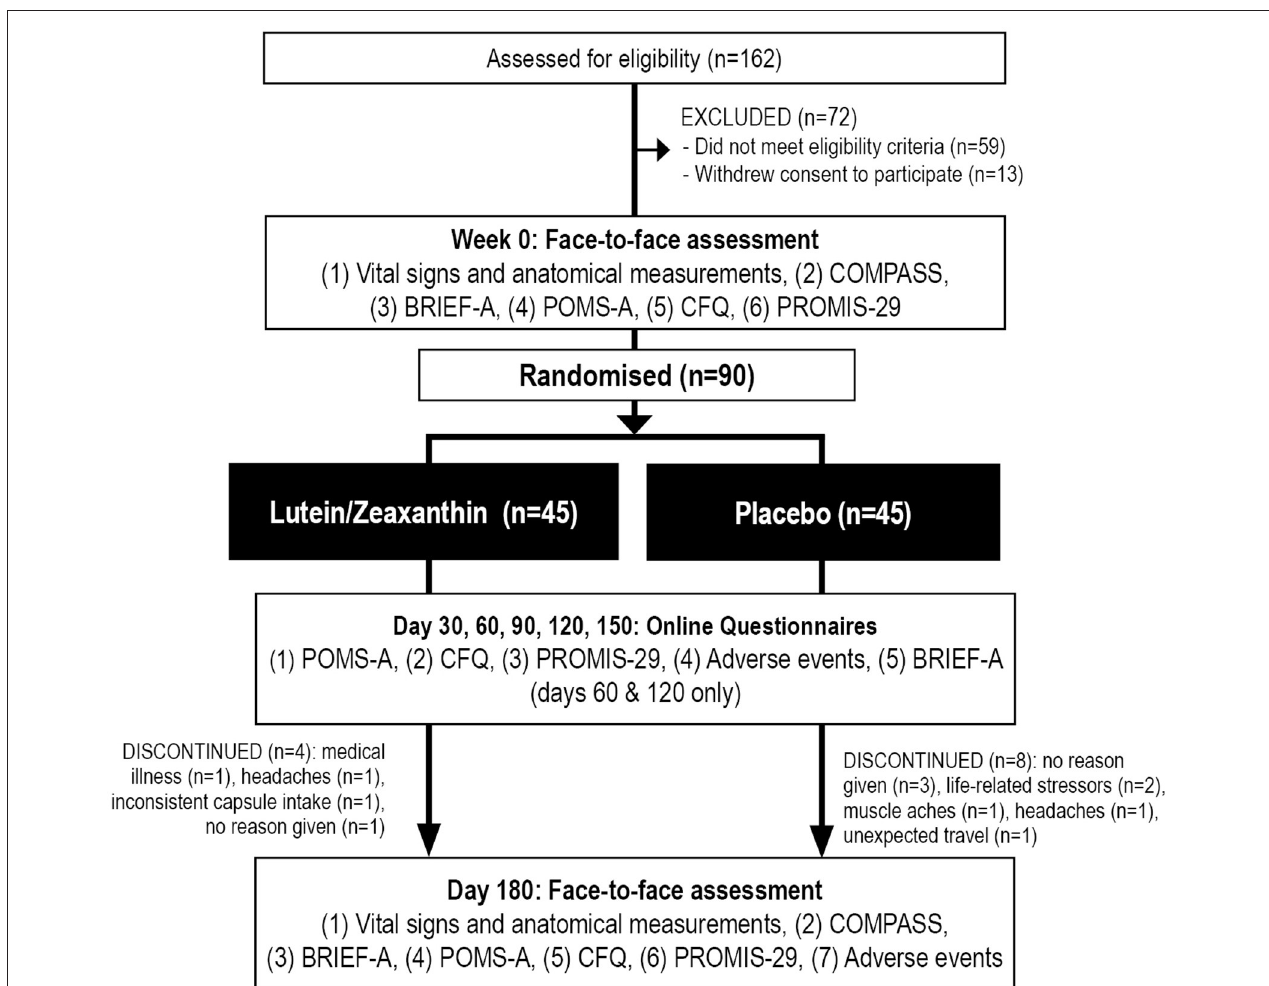
FIGURE 1 | Systematic illustration of study design. BRIEF-A, Behavior Rating Inventory of Executive Function—Adult Version; CFQ, Cognitive Failures Questionnaire; COMPASS, Computerized Mental Performance Assessment System; POMS-A, Profile of Mood States, Abbreviated Version; PROMIS-29, Patient-Reported Outcomes Measurement Information